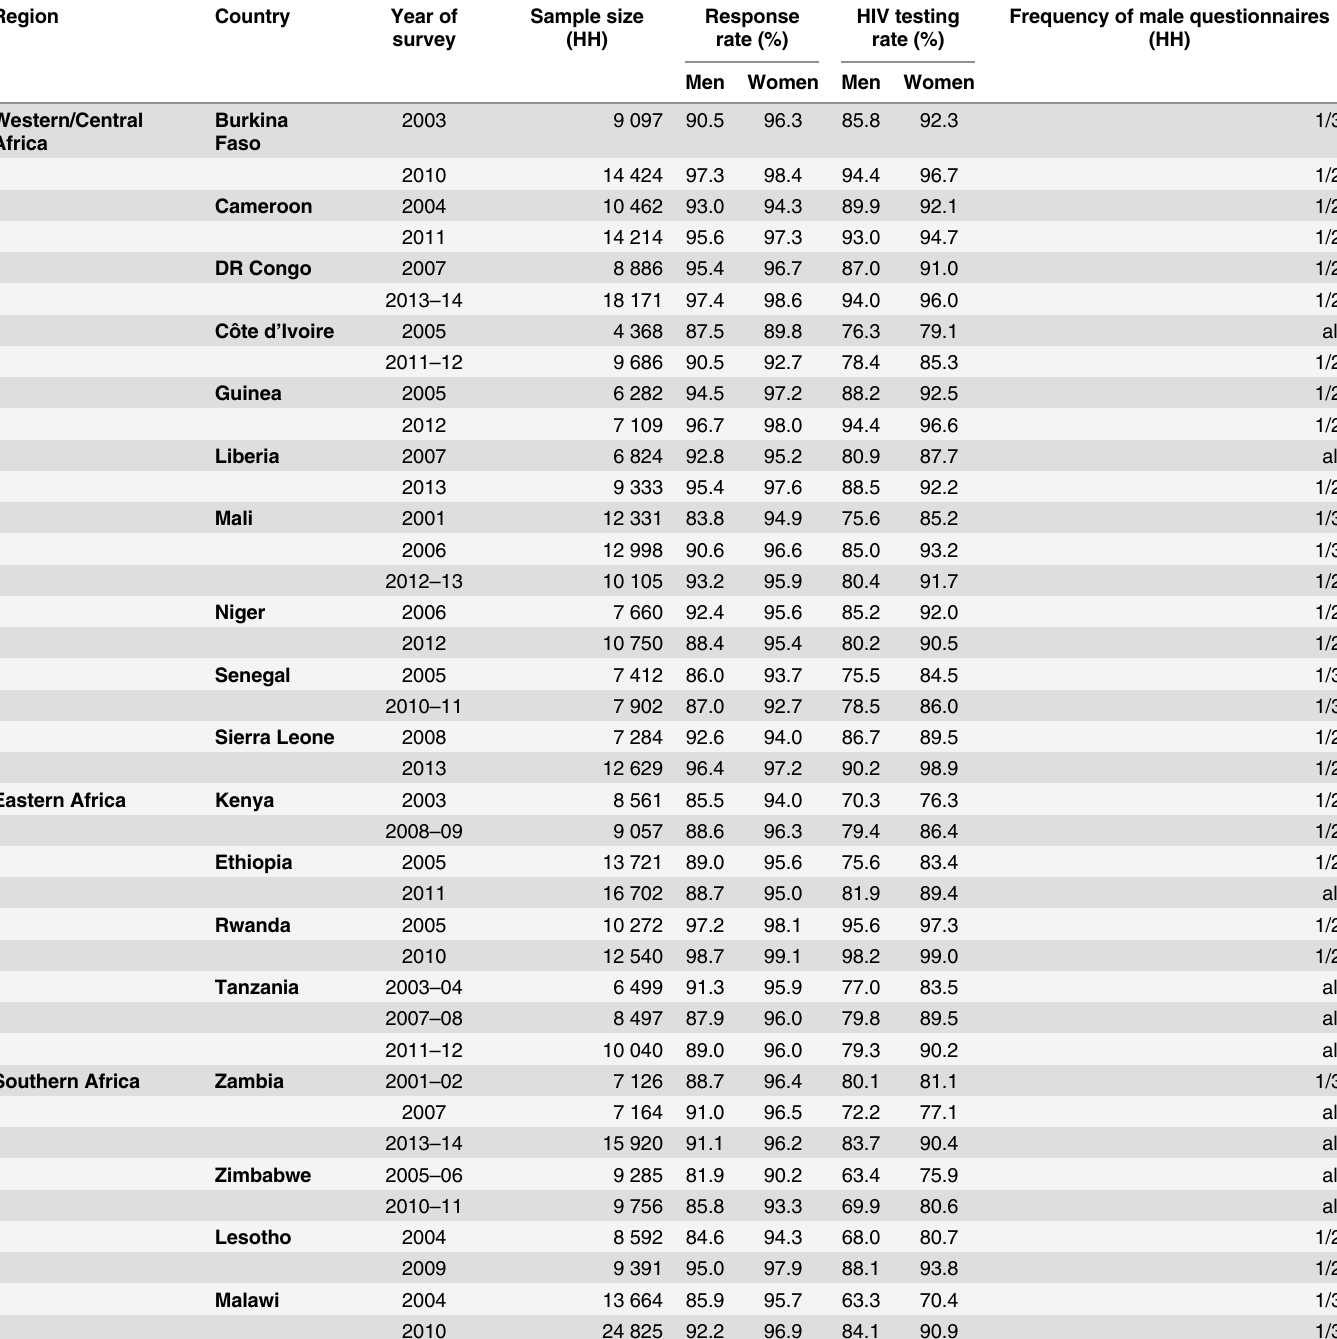
Table 1. Countries included and details of survey, by region.